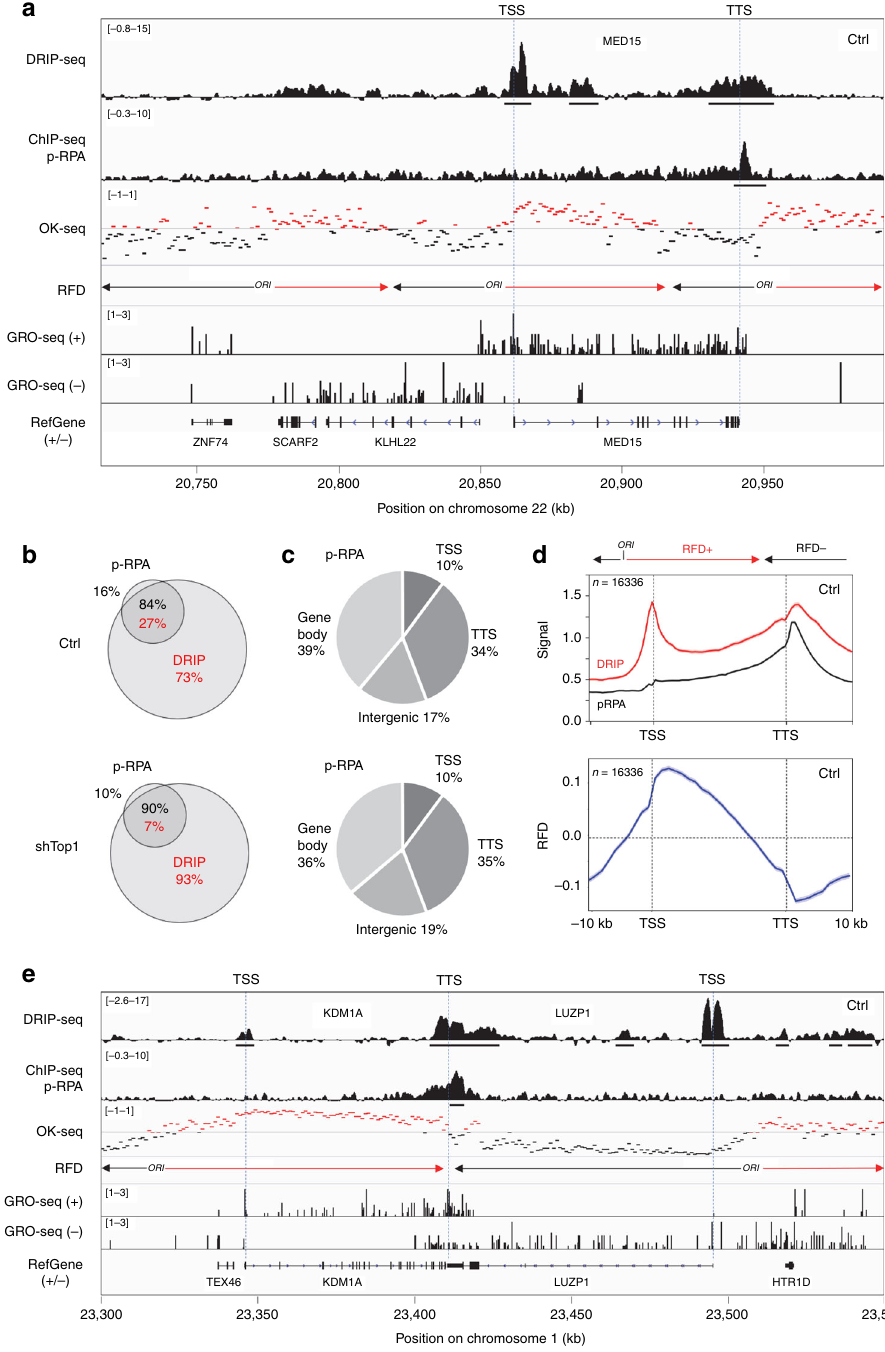
Fig. 2 Phospho-RPA accumulates at TTS in control and shTop1 cells. a Distribution of RNA:DNA hybrids (DRIP-seq), p-RPA32 S33 (ChIP-seq), Okazaki fragments (OK-seq), and nascent transcription (GRO-seq) signals at a representative region on chromosome 22 in control HeLa cells. Replication fork direction (RFD) is derived from OK-seq data. The positions of TSS and TTS are indicated for the MED15 gene. The positions of DRIP and p-RPA peaks identi fi ed with MACS2 are also indicated. b Venn diagram of the percentage of genes overlapping with R-loop (red) and p-RPA peaks (black) peaks (MACS2) in control and shTop1 cells. c The distribution of p-RPA peaks was analyzed with CEAS as in Fig. 1e. The percentage of p-RPA peaks present in each region is indicated. d Metaplots of RNA:DNA hybrids (DRIP, red), p-RPA (black), and replication fork direction (RFD, blue) at 16,336 active genes in HeLa cells. Error bars indicate SEM. e Distribution of RNA:DNA hybrids (DRIP-seq), p-RPA32 S33 (ChIP-seq), Okazaki fragments (OK-seq), and nascent transcription (GRO-seq) signals at two converging genes on chromosome 1 in control HeLa cells. The positions of DRIP and p-RPA peaks identi fi ed with MACS2 are